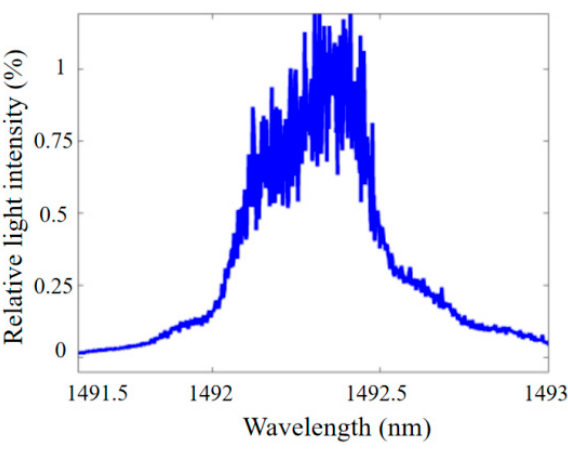
Figure 7. The output spectrum of signal laser without F–P etalon inserted.